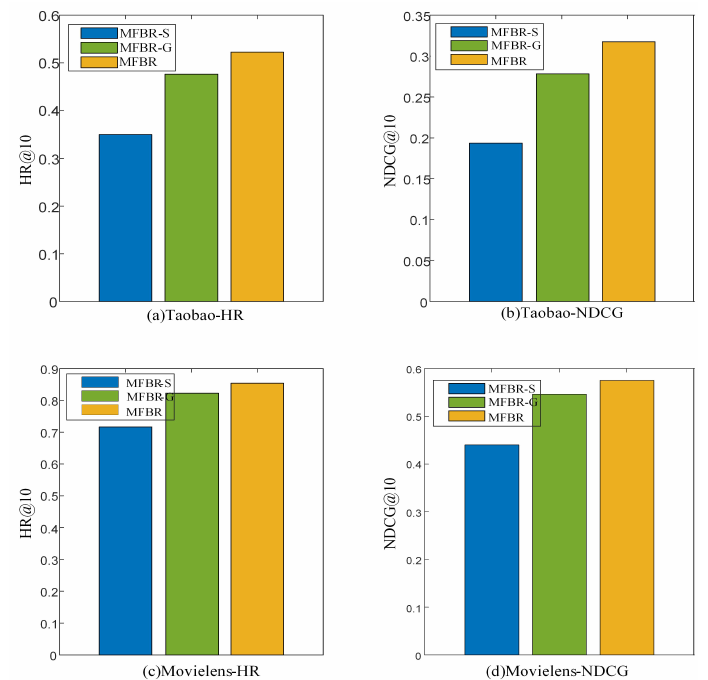
Figure 3. Case study on the MFBR